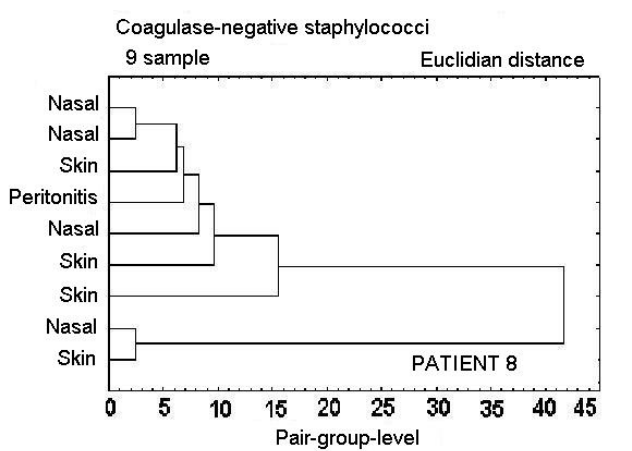
Figure 4: Similarity dendrogram drawn based on inhibition halos obtained by using the agar disk diffusion technique for coagulase-negative staphylococci isolated from the nasal cavity, pericatheter skin and peritoneal effluent of one patient undergoing peritoneal dialysis.